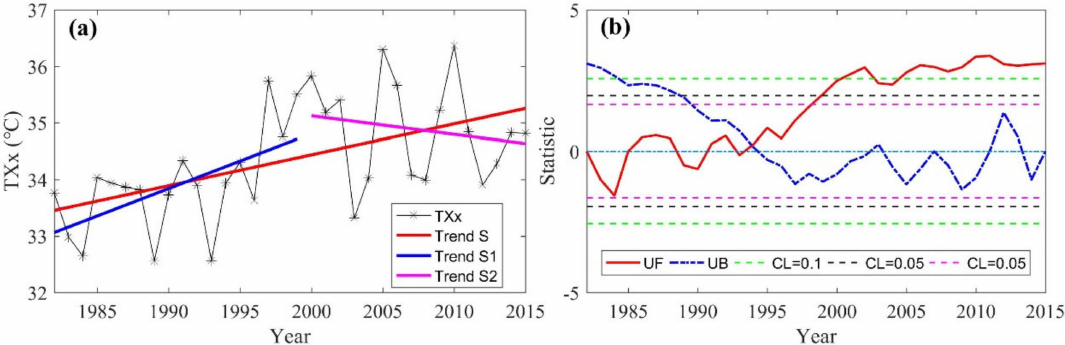
Figure 7. Trend change and abrupt trend analyses of the Loess Plateau region, ( a ) refers to the trend of TXx during S, S1 and S2 periods, respectively, while ( b ) is the Mann–Kendall trend analysis and confidence level test of TXx during S period, UF and UB refer to the forward and backward statistics of standardized variables,